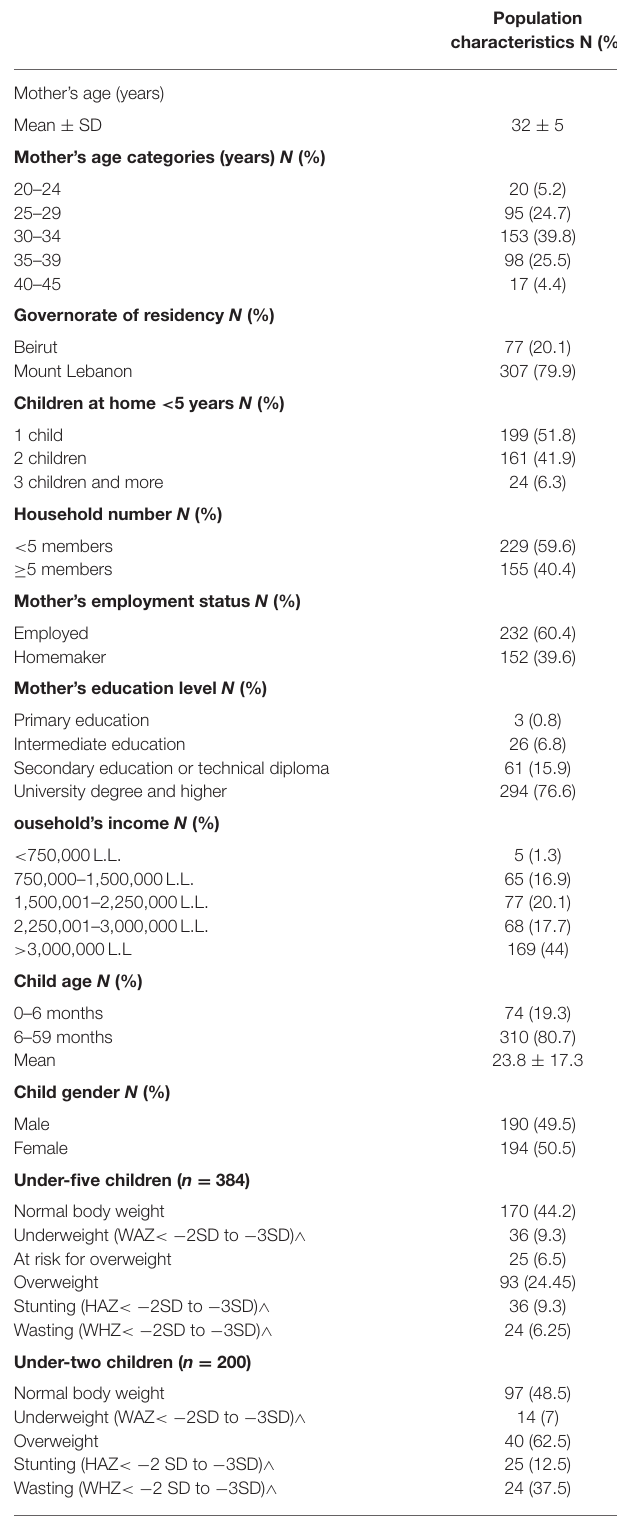
TABLE 1 | Socio-demographic, weight status, and household characteristics of Lebanese infants and young children aged less than 5 years old.